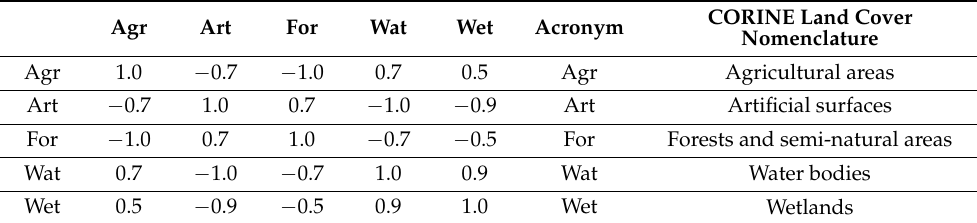
Table 8. Spearman’s rank correlation coefficient in the Azores